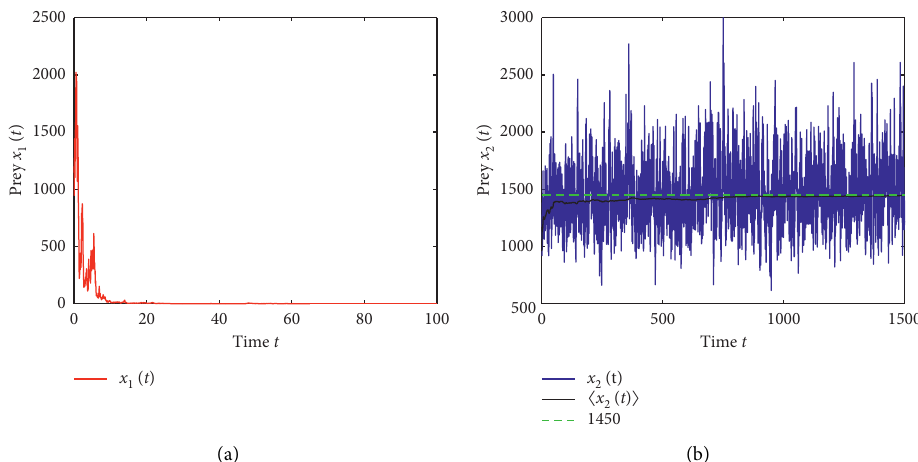
Figure 10: The trajectories of stochastic model (5) with σ 2 x ( t ) and (b) prey x 1